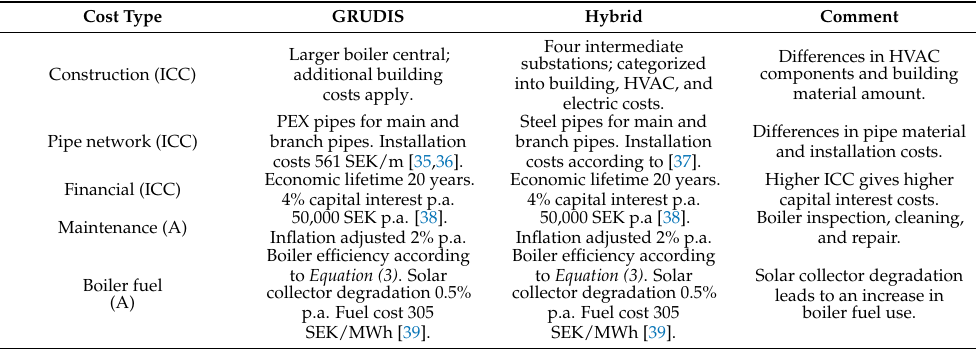
Table 8. LCC types—Overview of cost types included in the LCC for the hybrid and GRUDIS distribution concepts. The LCC cost category is included in parenthesis under the cost